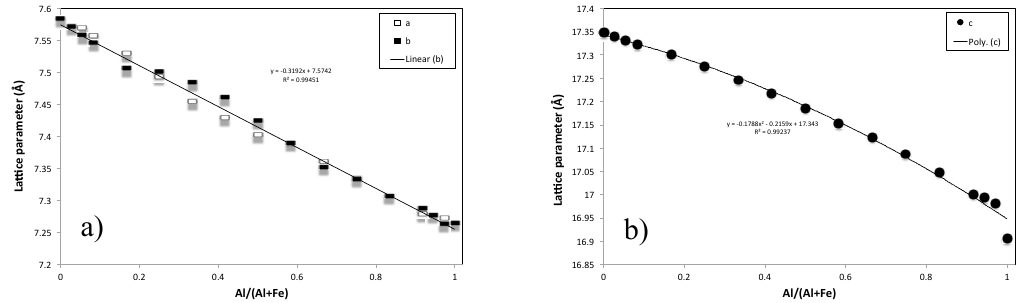
Figure 12. ( a ) a and b lattice parameter and ( b ) c lattice parameter versus Al mole fraction.